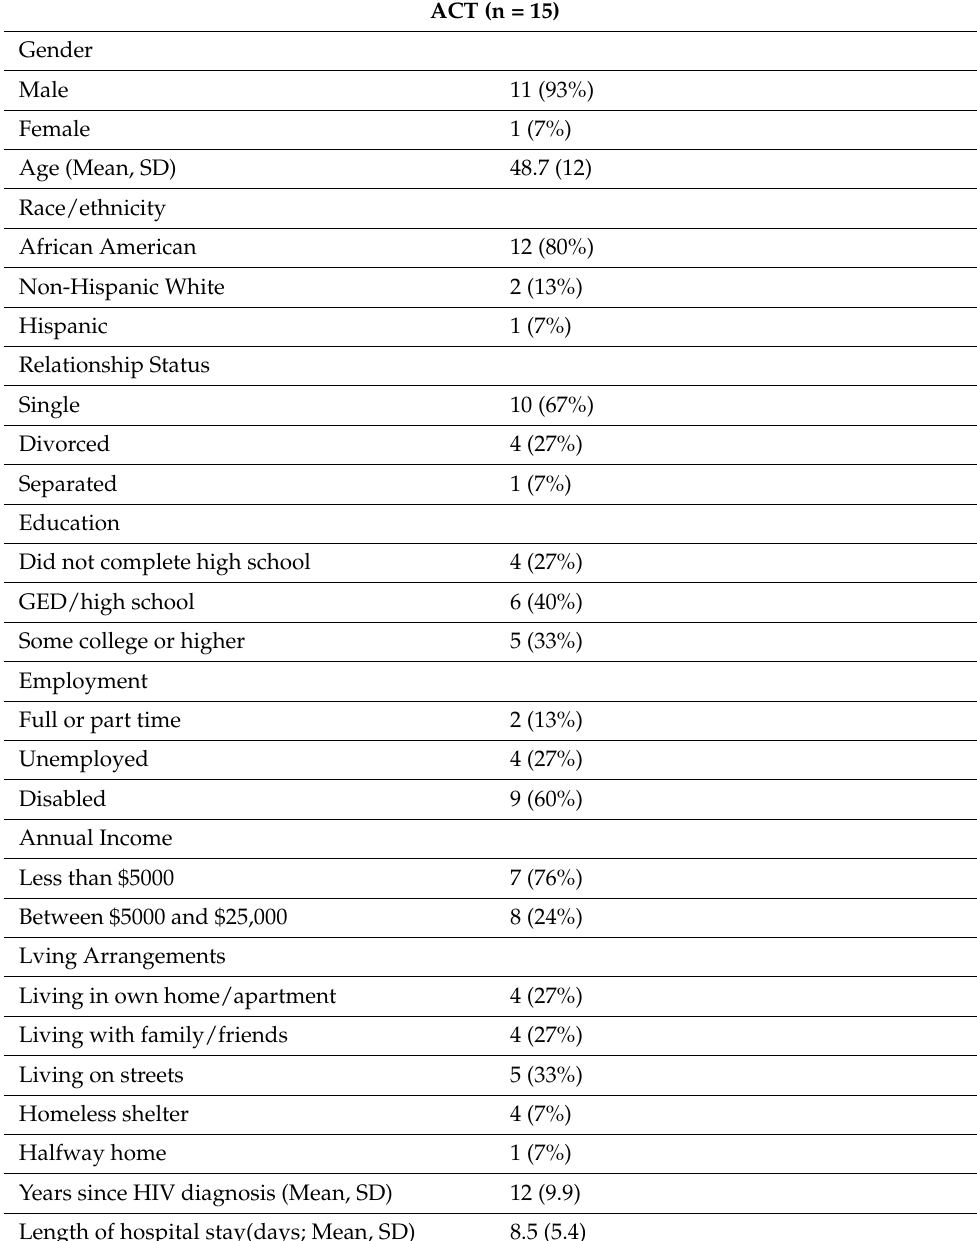
Table 1. Description of the